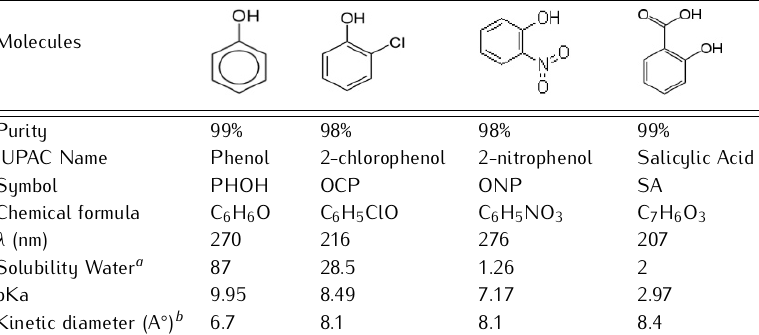
Table 2. Physicochemical properties of